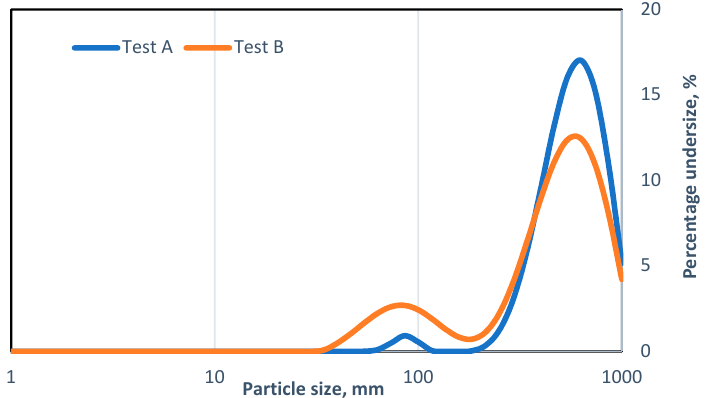
Figure 9. Product particle size distribution for two nozzles spraying downwards (Test A) and for lower nozzle spraying upwards (Test B) (adapted from Ref. [36]).